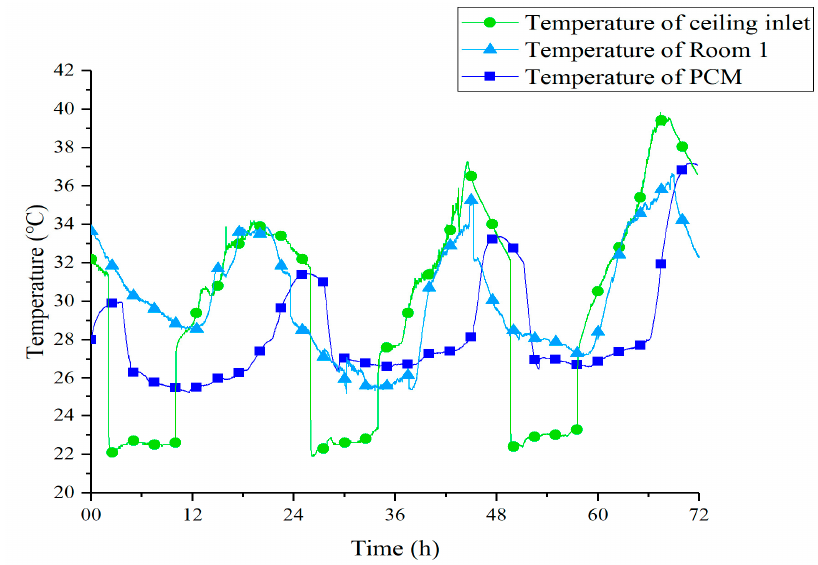
Figure 11. Temperature curves of PCM, tunnel outlet, and Room 2 under Strategy 2.